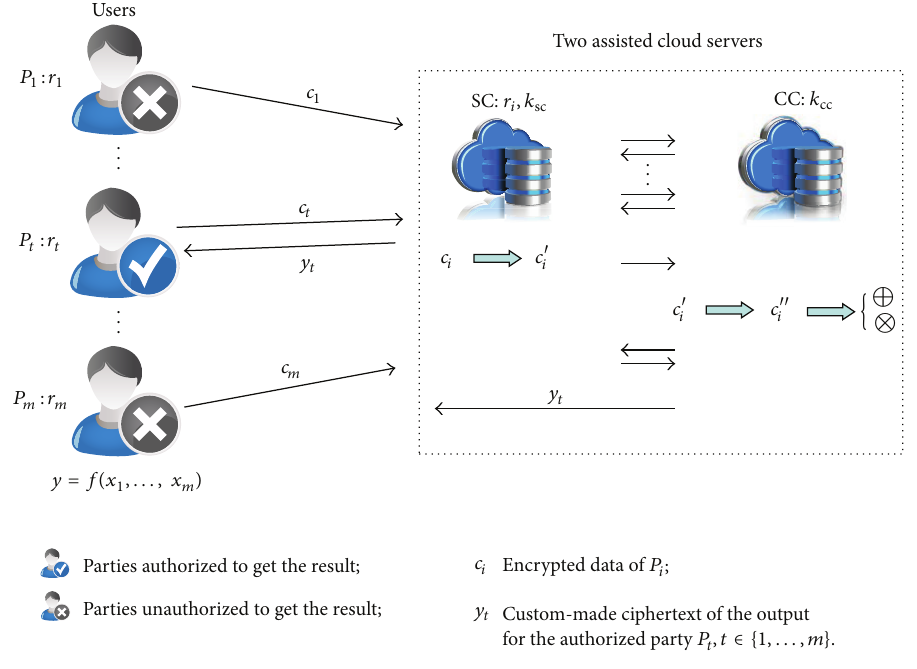
Figure 1: Framework of our